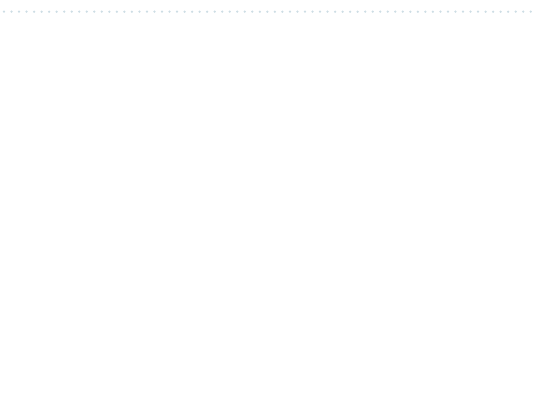
Figure 6. Prosthesis Measurement of Independent Functions (PMIF) pre and post intervention time averages for activities.